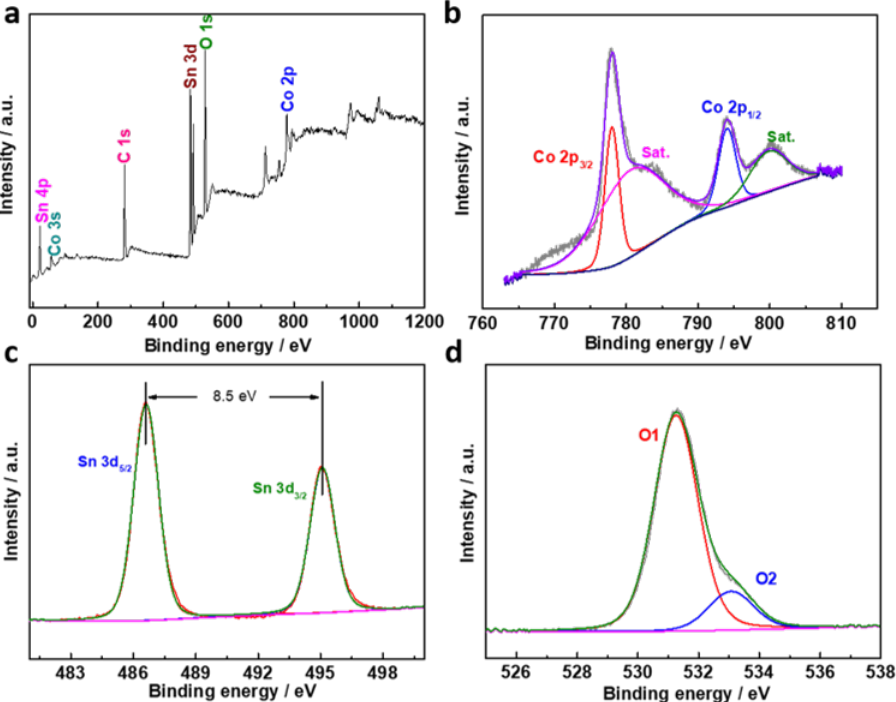
Figure 3. XPS spectra of hollow CoSn(OH) 6 sample. ( a ) Survey spectrum, ( b ) Co 2p, ( c ) Sn 3d, and ( d ) O 1s high-resolution XPS spectra.